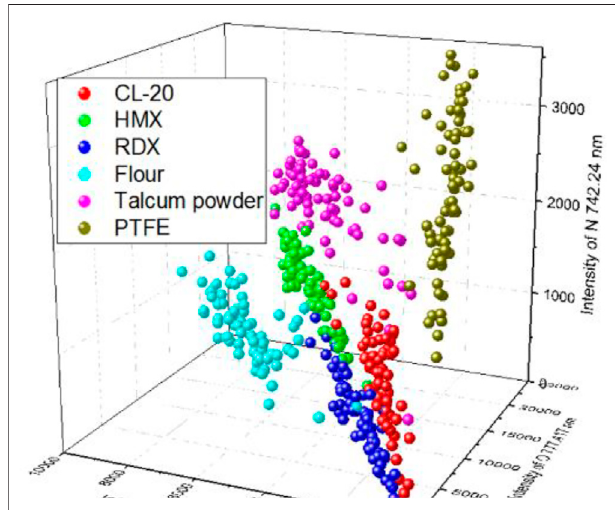
FIGURE 5 | 3D plot of the intensity of H 656.28 nm, O 777.417 nm, and N 742.24 nm.